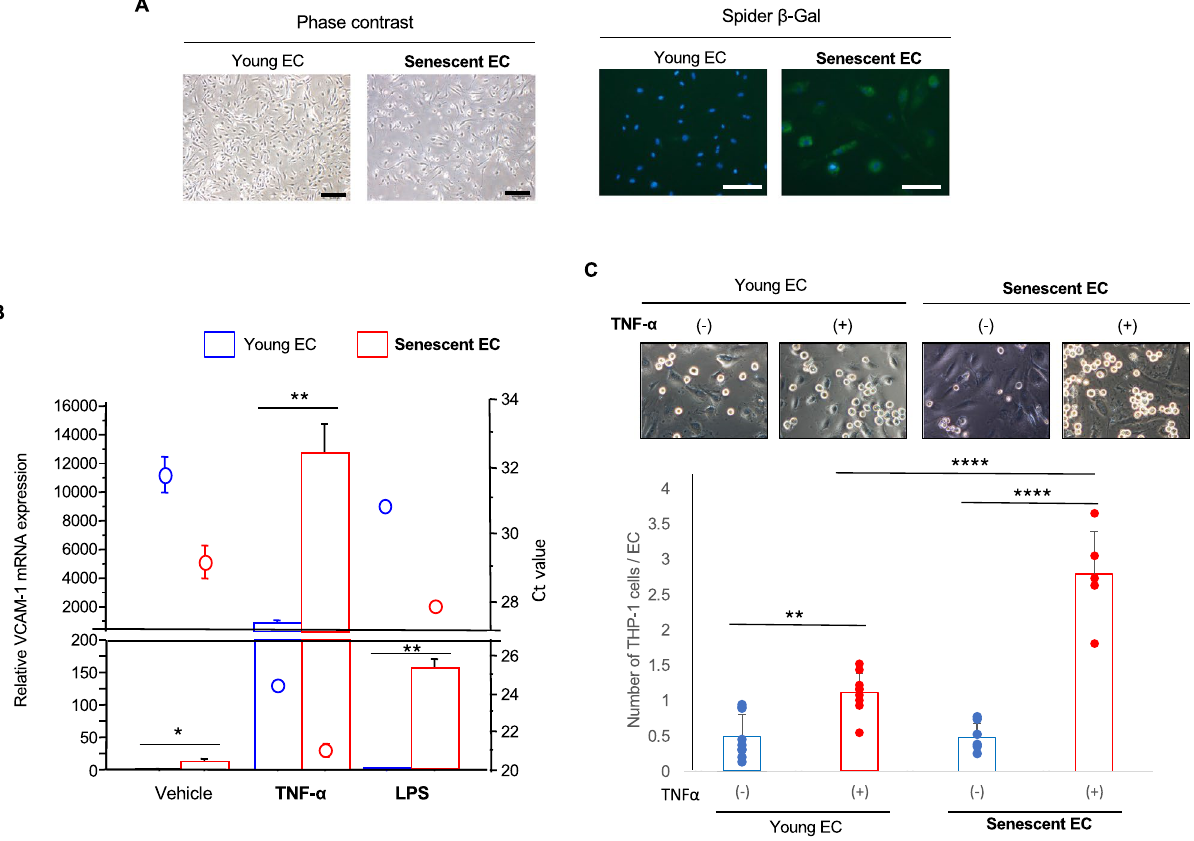
Figure 3. Senescent EC is hypersensitive to inflammatory stimuli. ( A ) Replicative senescent HUVECs were prepared. Senescent ECs showed flattened and enlarged morphology, and senescence-associated β-Gal activity. Bars: 200 μm. ( B ) Quantitative PCR analysis for VCAM-1 in ECs (n = 7 each for vehicle group; n = 3 each for TNF-α and LPS groups). Young control and senescent ECs were treated with 1 ng/ml TNF-α or 5 ng/ml LPS for 24 h. ( C ) Young control and senescent ECs were treated with 1 ng/ml TNF-α for 24 h, and then THP-1 monocyte adhesion was examined (n = 9 for young ECs: n = 5–6 for senescent ECs). Bars: 100 μm. Data are presented as mean ± SEM. * p < 0.05, ** p < 0.01, and **** p <